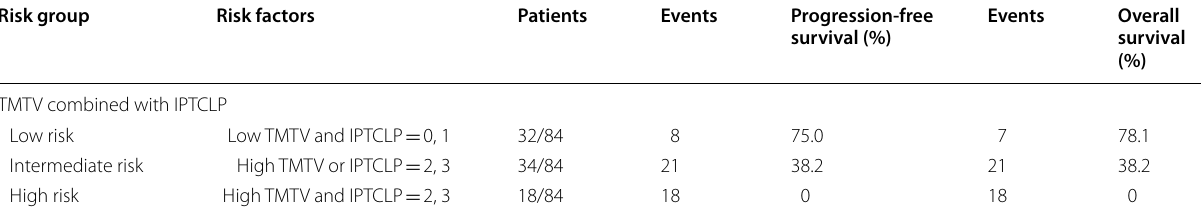
Table 7 Risk stratification and outcomes of progression-free and overall survival Risk group Risk factors